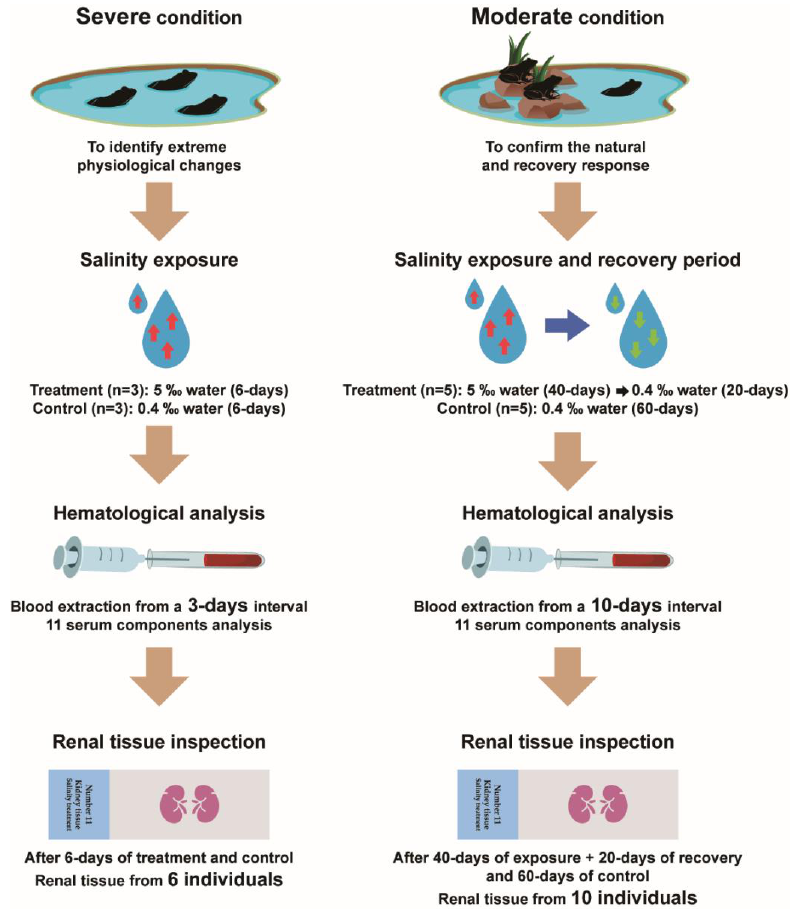
Figure 1. Flow chart for the present study. Wild-caught frogs were raised in treatment and control groups exposed to two conditions, moderate and severe saline exposure. In both groups, blood serum chemistry analysis and renal tissue inspection were used to identify physiological changes in frogs.